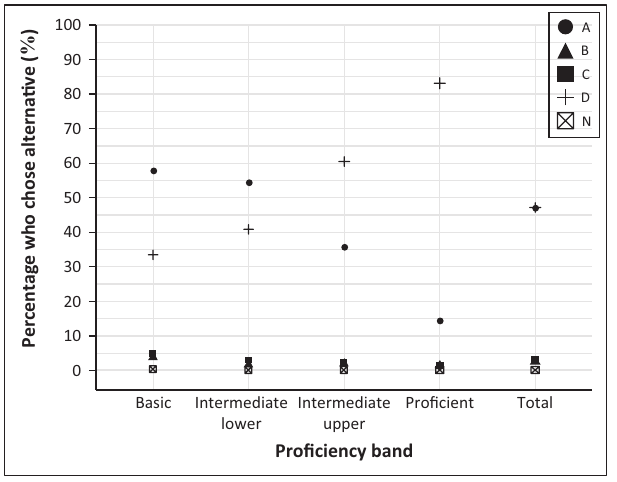
FIGURE 11: For a question requiring converting to square units, the proportions of students who chose each alternative answer, for the total cohort and for each proficiency